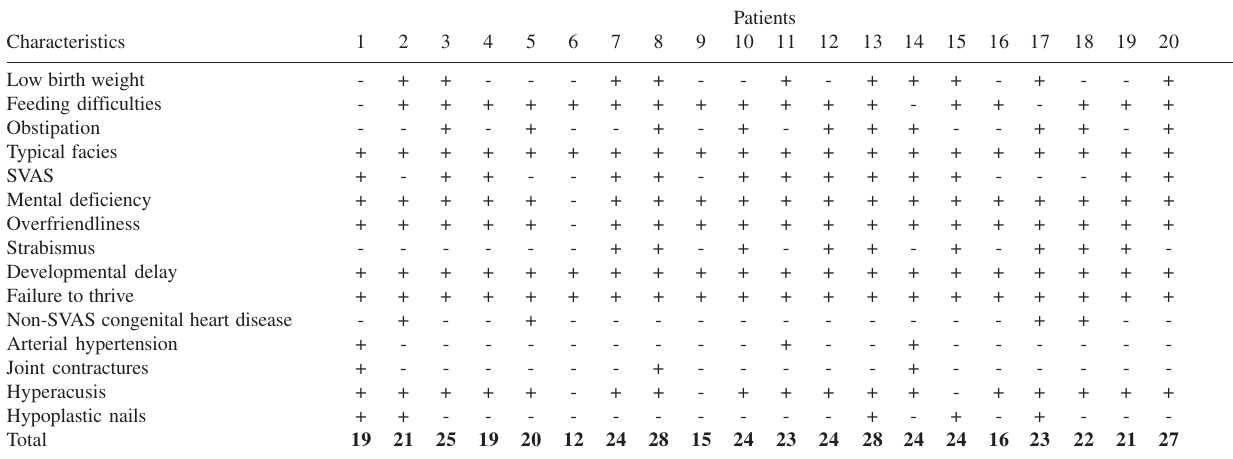
Table 2 - Phenotype scoring system of the present work applied with our 20 patients